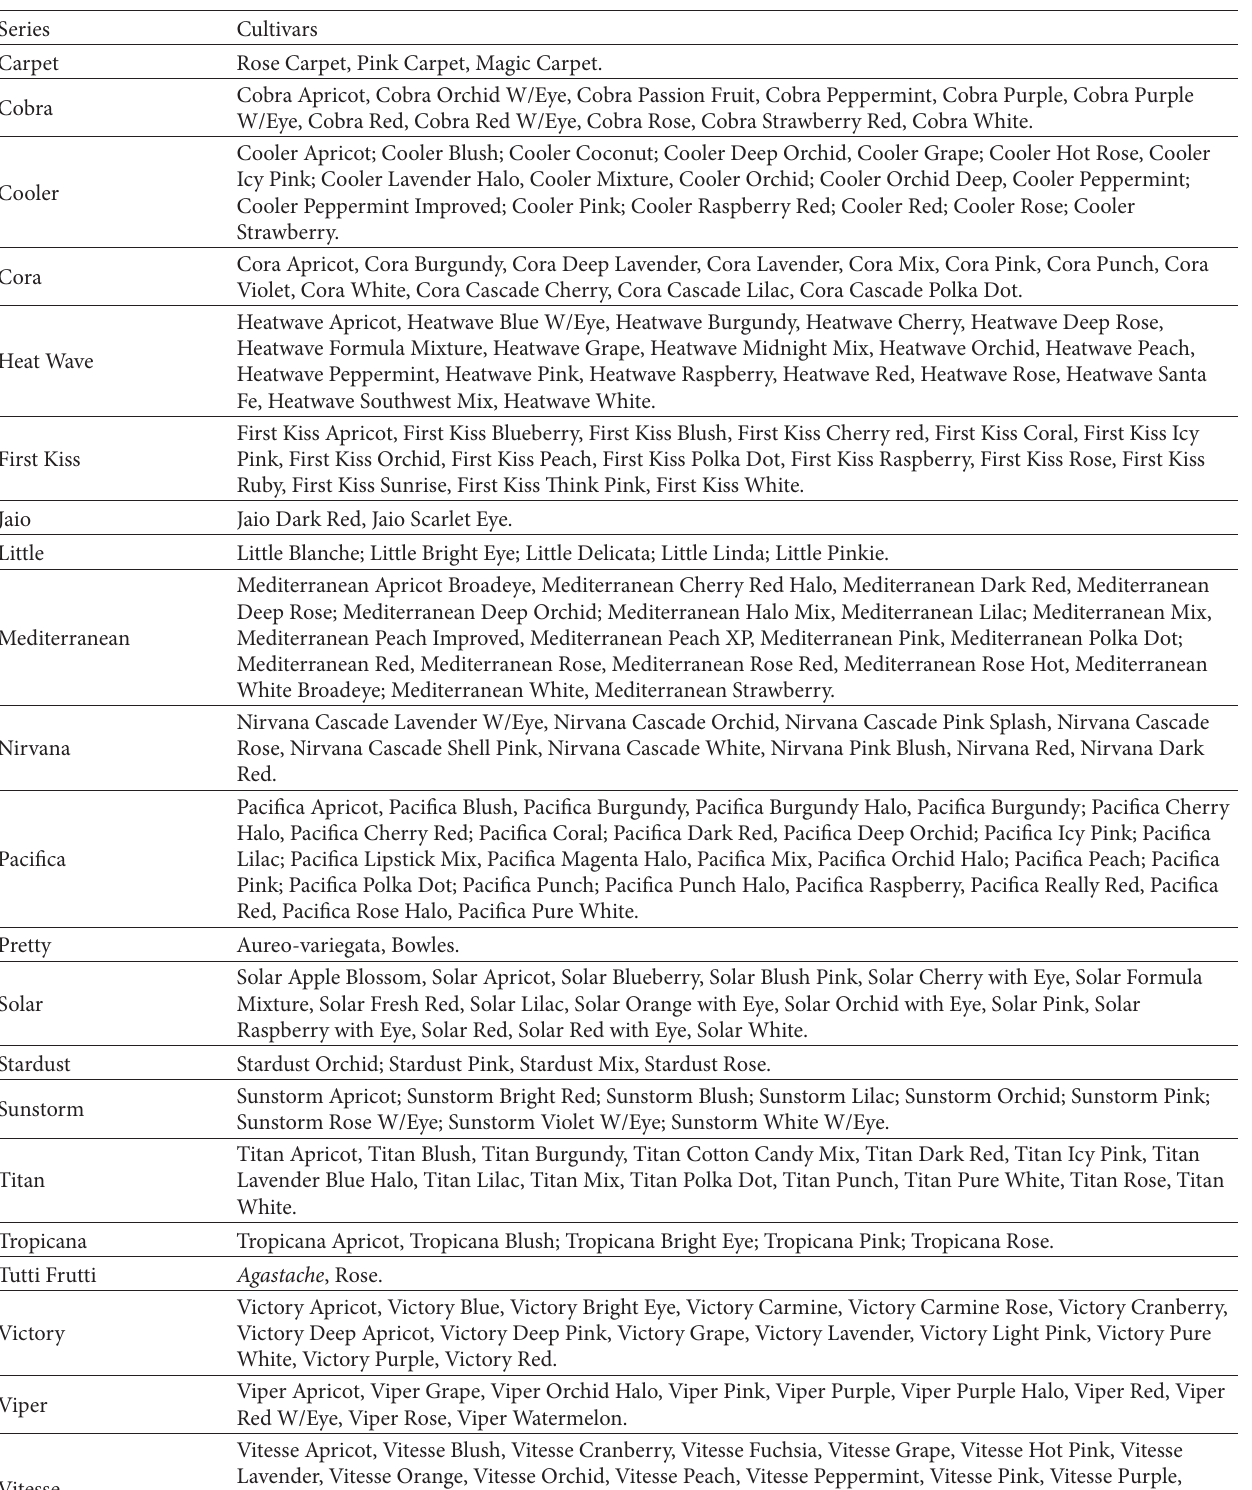
Table 4: Available cultivars of Catharanthus roseus